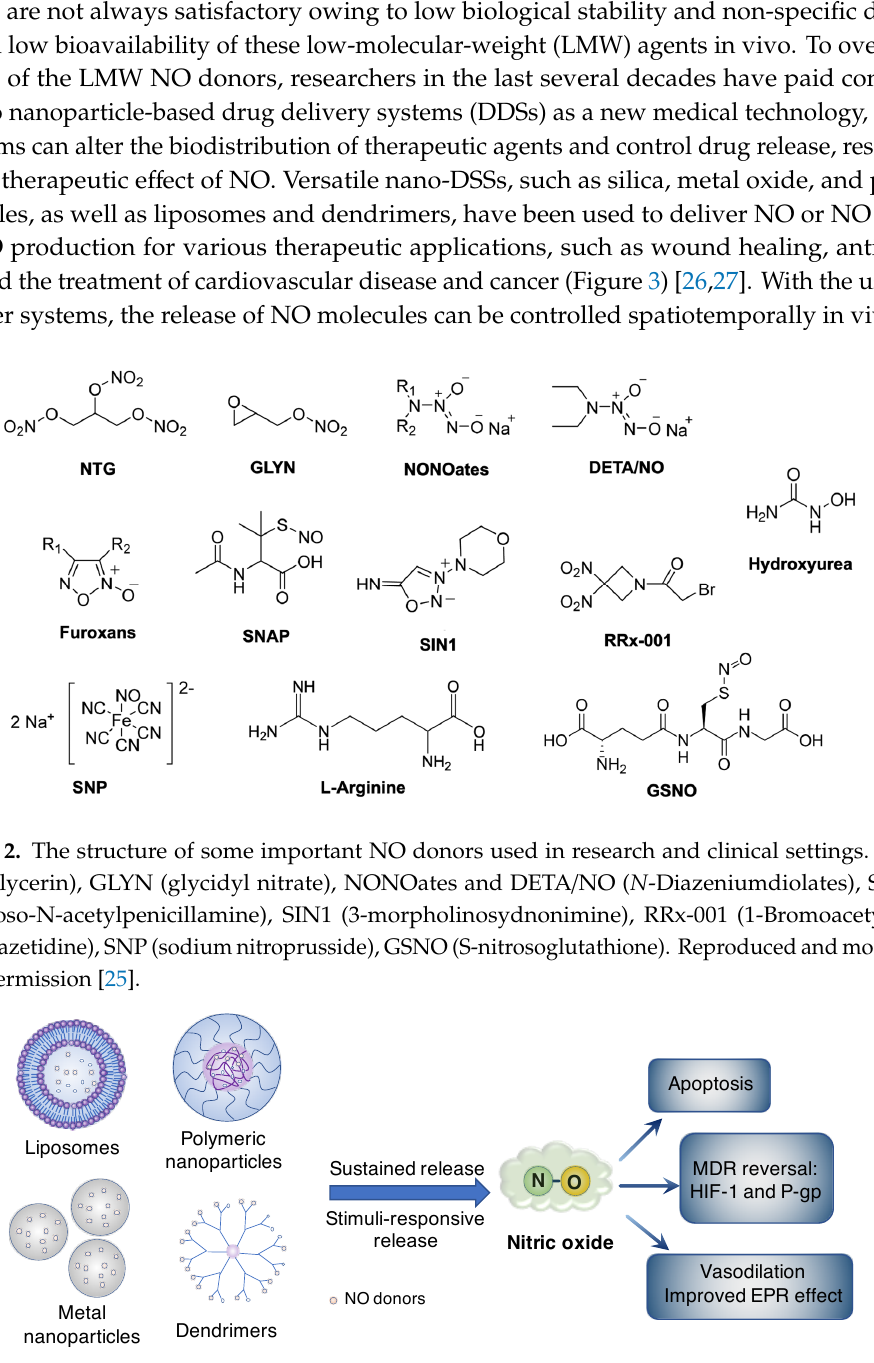
Figure 3. Nanocarriers used to deliver nitric oxide (NO) and the therapeutic e ff ects of NO in cancer. Nanocarriers, such as liposomes, polymeric nanoparticles, metal nanoparticles, and dendrimers, are widely used to improve the stability of NO donors to deliver these molecules to the tumor tissue, where the NO release is triggered by the internal or external stimuli. The NO released from of reversal of multidrug resistance (MDR) via inhibition of hypoxia-inducible factor-1 (HIF-1) and P-glycoprotein (P-gp) expression, and improve the enhanced permeability and retention (EPR) e ff ect via NO-induced